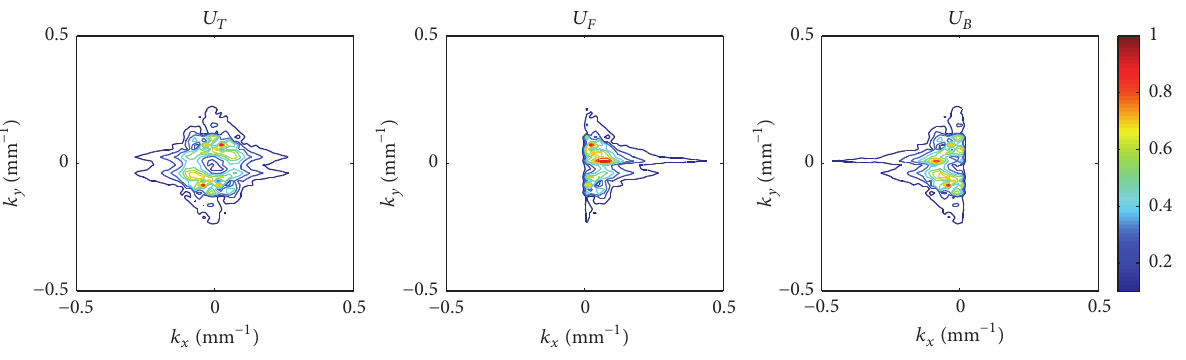
Figure 6: Wavenumber plots of 𝑈 𝑇 , 𝑈 𝐹 , and 𝑈 𝐵